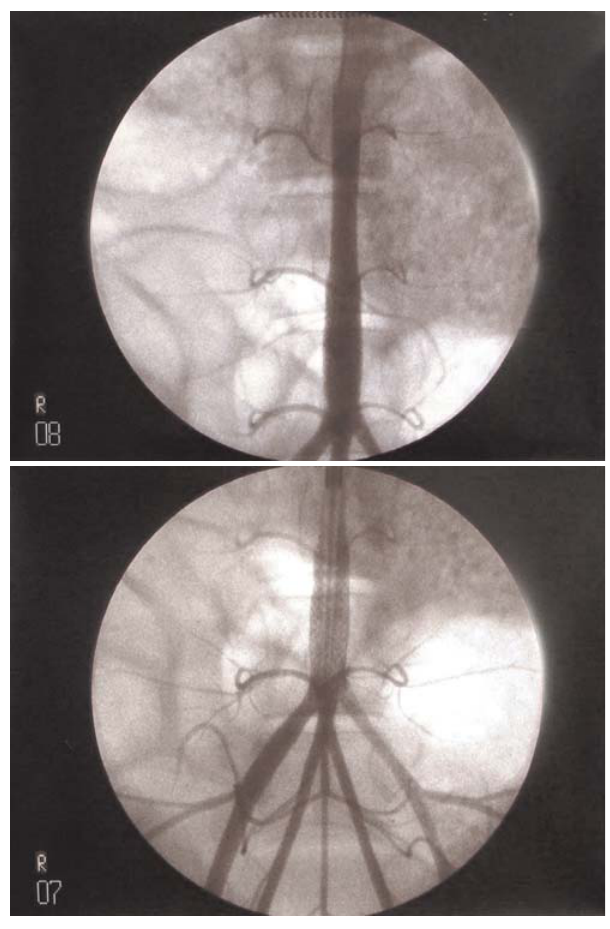
Figure 1 - Angiography after stent deployment in pig